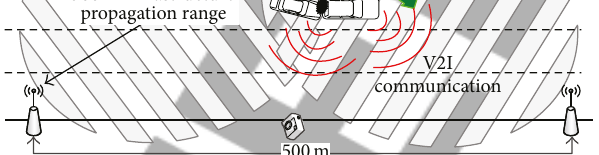
Figure 5: Deployment of VANET-based incident detection along the